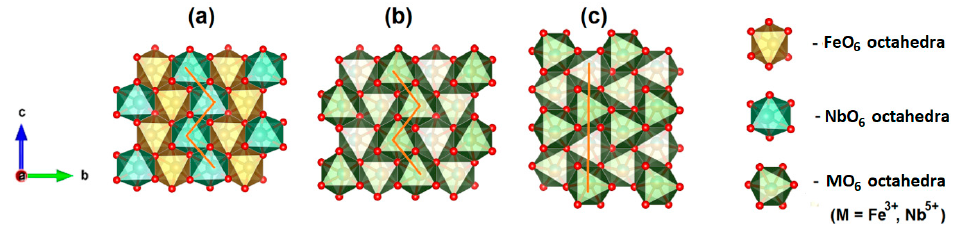
Figure 2. Schematic illustrations of crystal structures of FeNbO 4 (drawn using VESTA software, version 3): ( a ) monoclinic; ( b ) orthorhombic; ( c ) tetragonal.